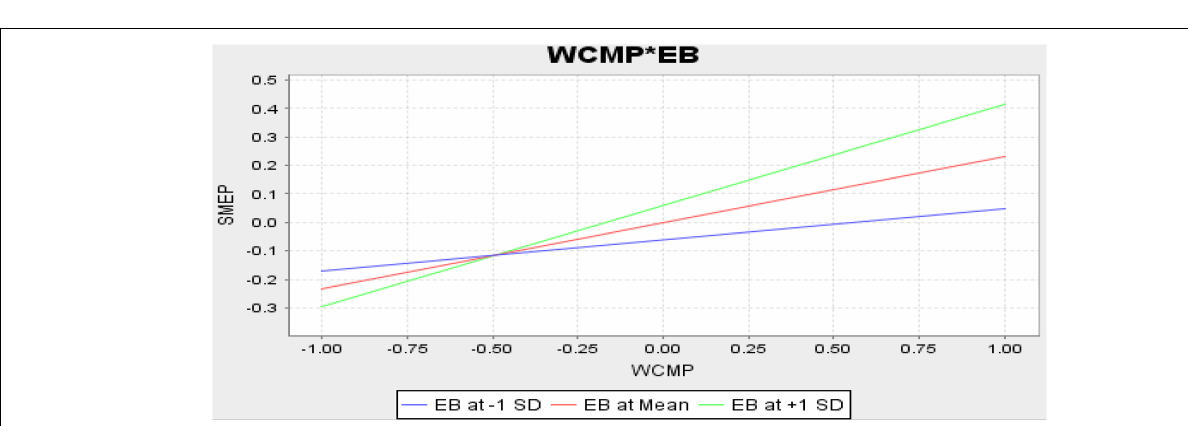
FIGURE 7 | Working capital management practices (WCMP) × Employee behavior